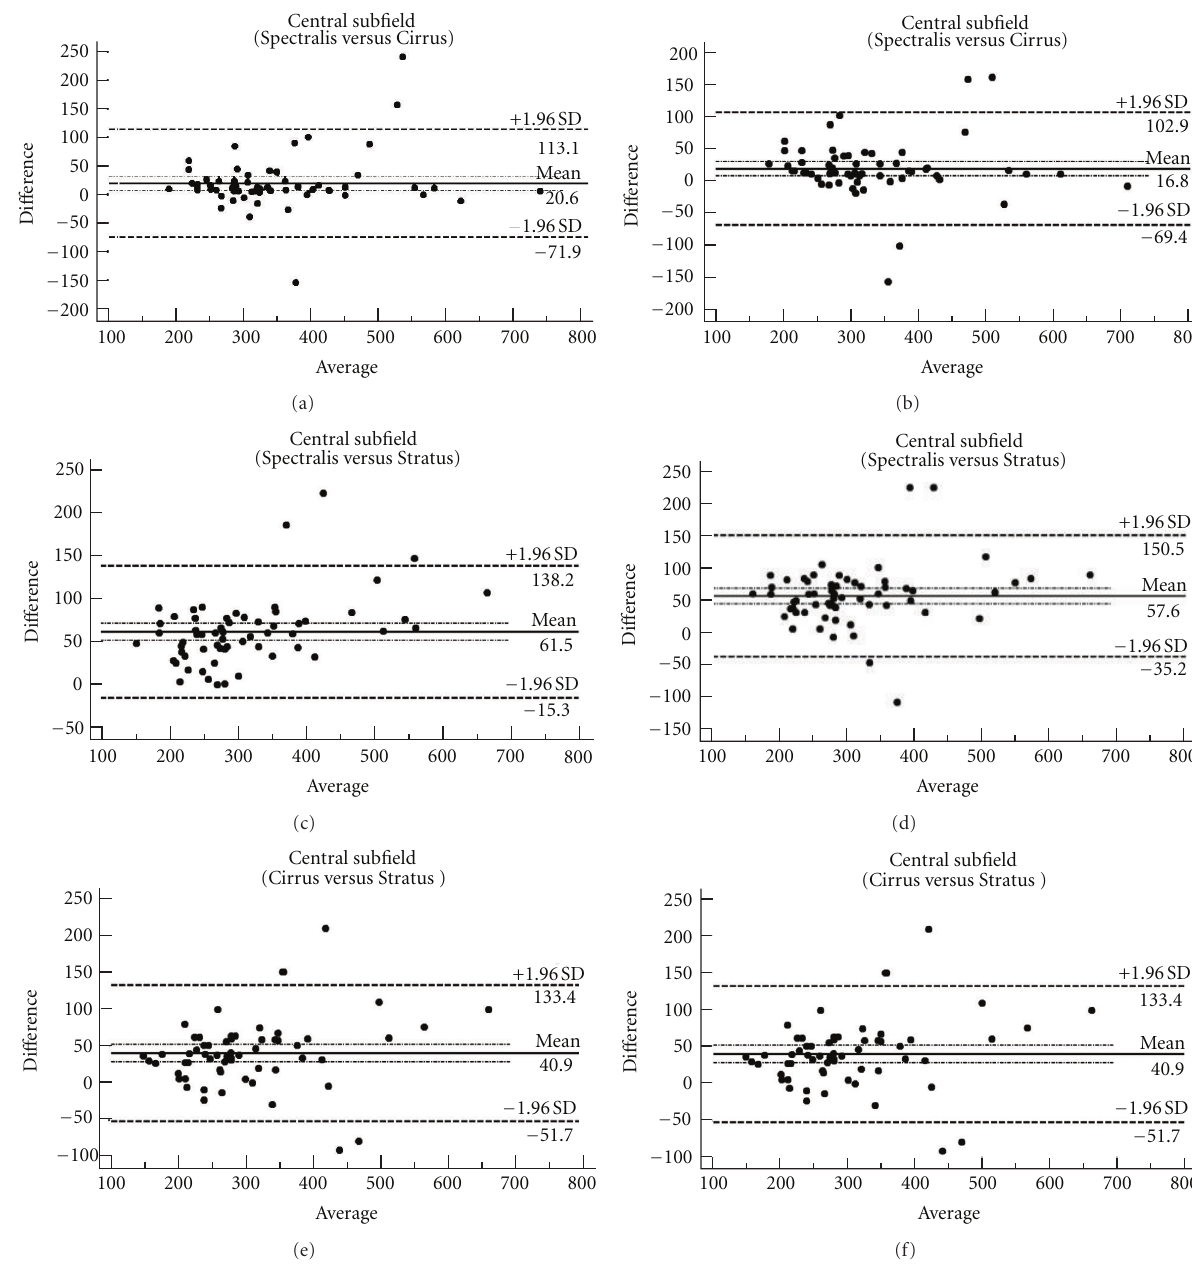
Figure 1: Bland-Altman plots of central subfield macular thickness between each device for the values before manual correction of algorithms (a, c, and e) and after manual correction (b, d, and f) in eyes with diabetic retinopathy. Solid lines: average mean di ff erence; dotted lines: 95% confidence limits of